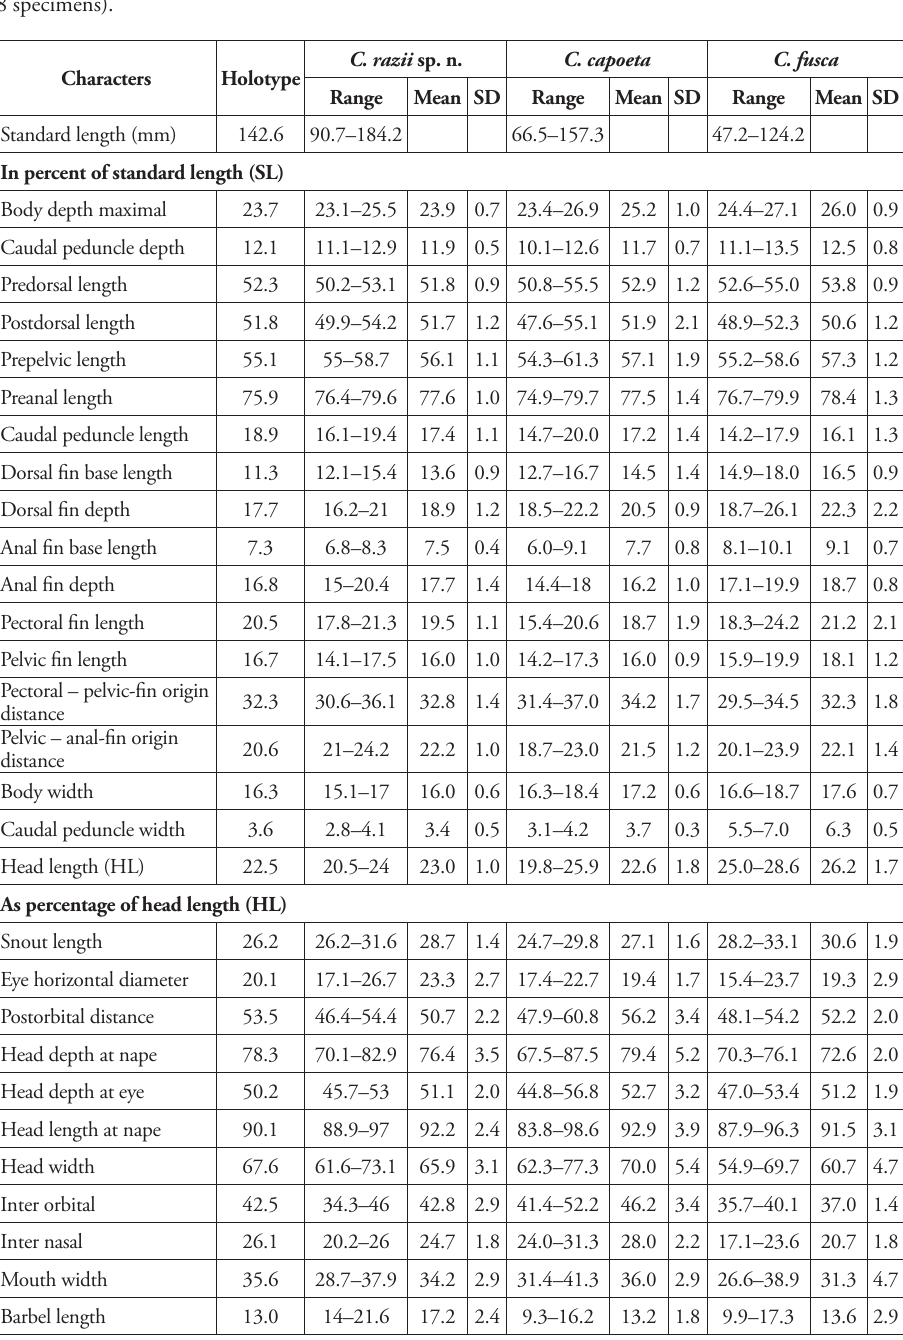
Table 4. Morphometric data of Capoeta razii sp. n. (holotype, IMNRF-UT-1072-9; paratypes, IMN- RF-1072, 14 specimens) C. capoeta (IMNRF-UT-1067, 15 specimens) and C. fusca (IMNRF-UT-1065, 8